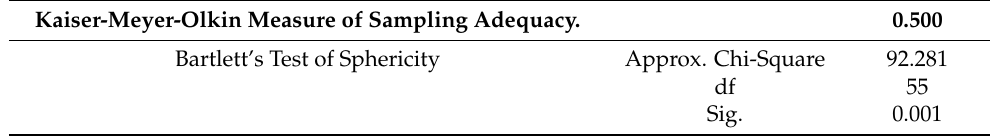
Table 7. KMO values to determine the validity of the survey. Kaiser-Meyer-Olkin Measure of Sampling